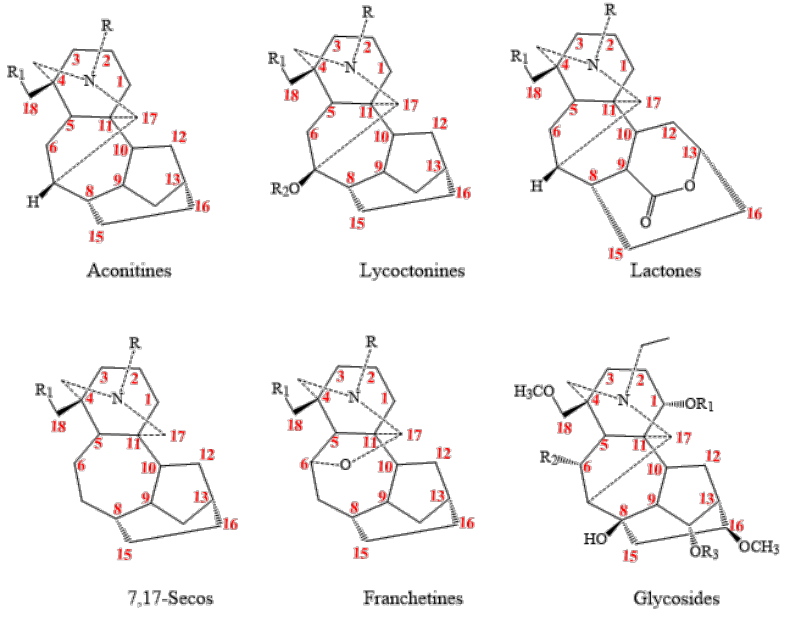
Figure 4. C 19 -DAs class. Figure 4. C 19 -DAs